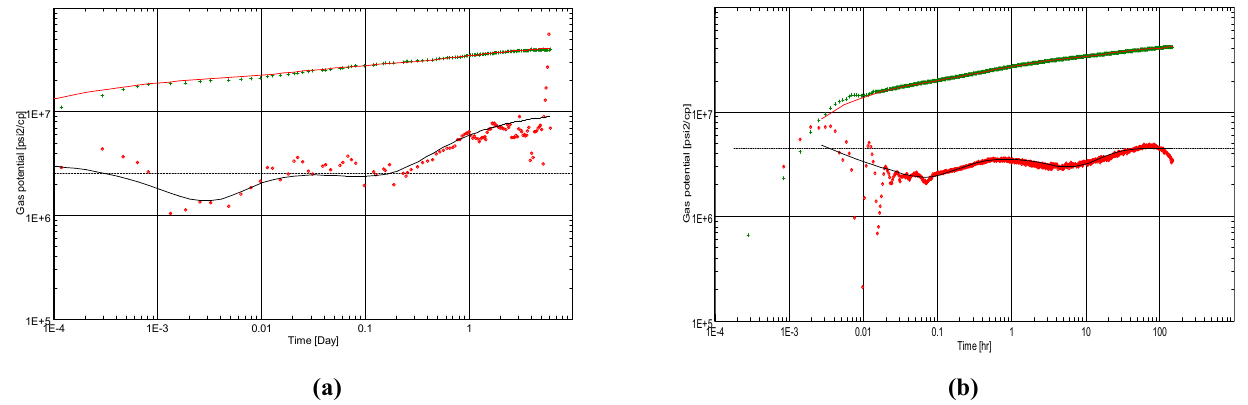
Figure 11—PTA results. (a) PTA with Converted Data. (b) PTA with PDHG Data.